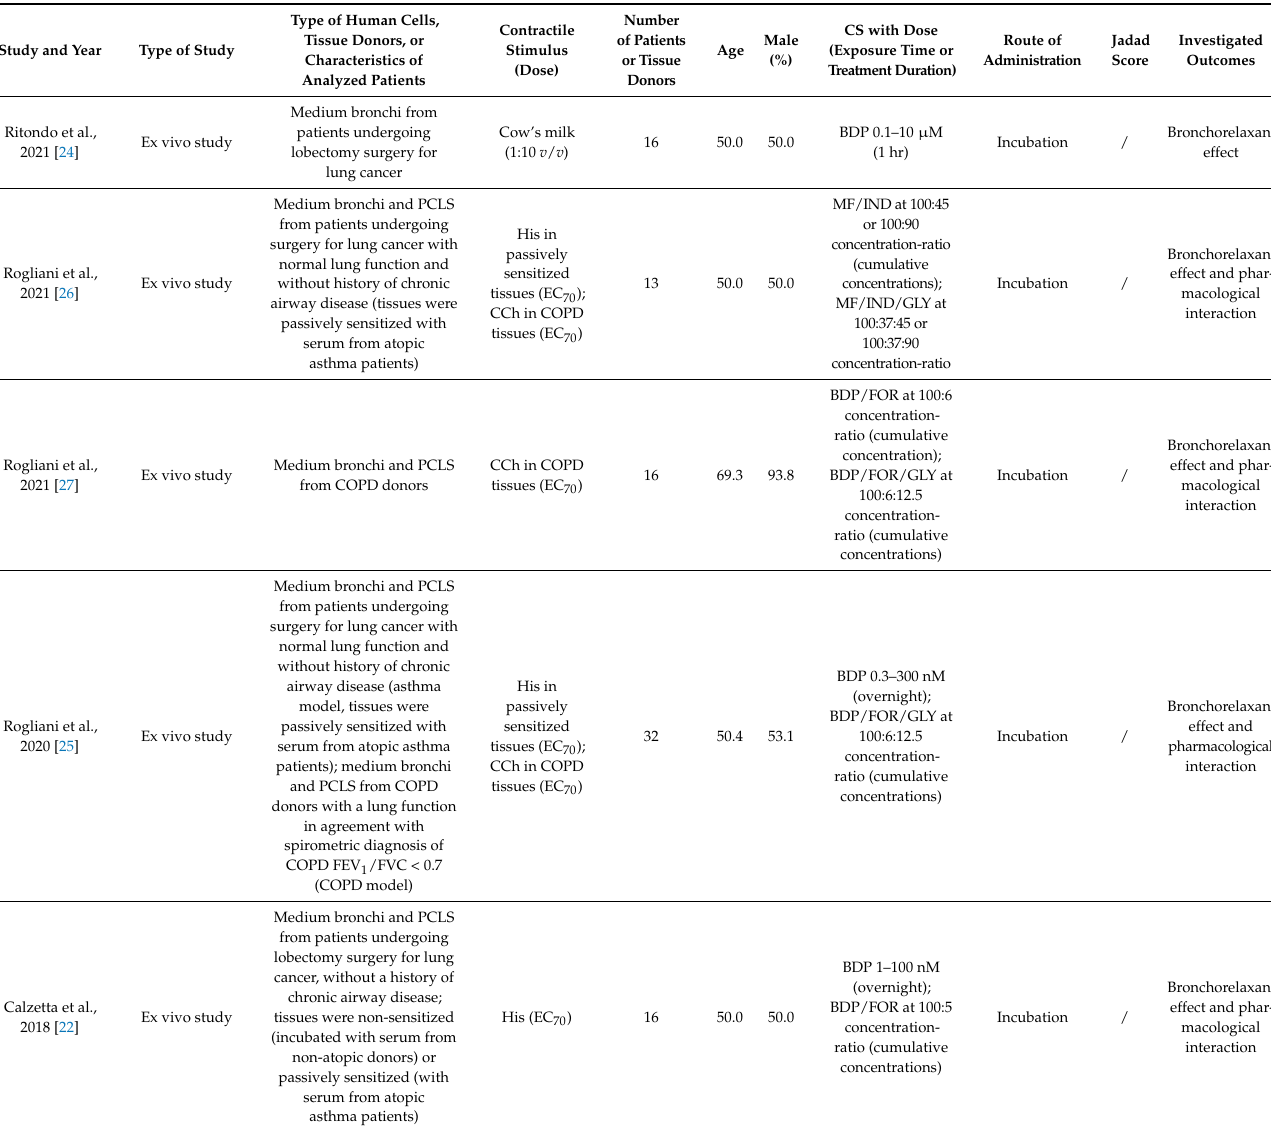
Table 1. Characteristics of the studies included in the systematic